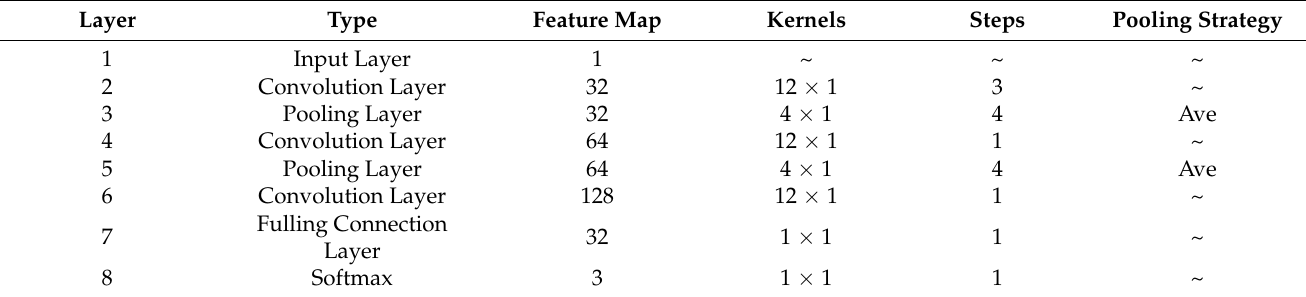
Table 1. Structure of CNN Model.